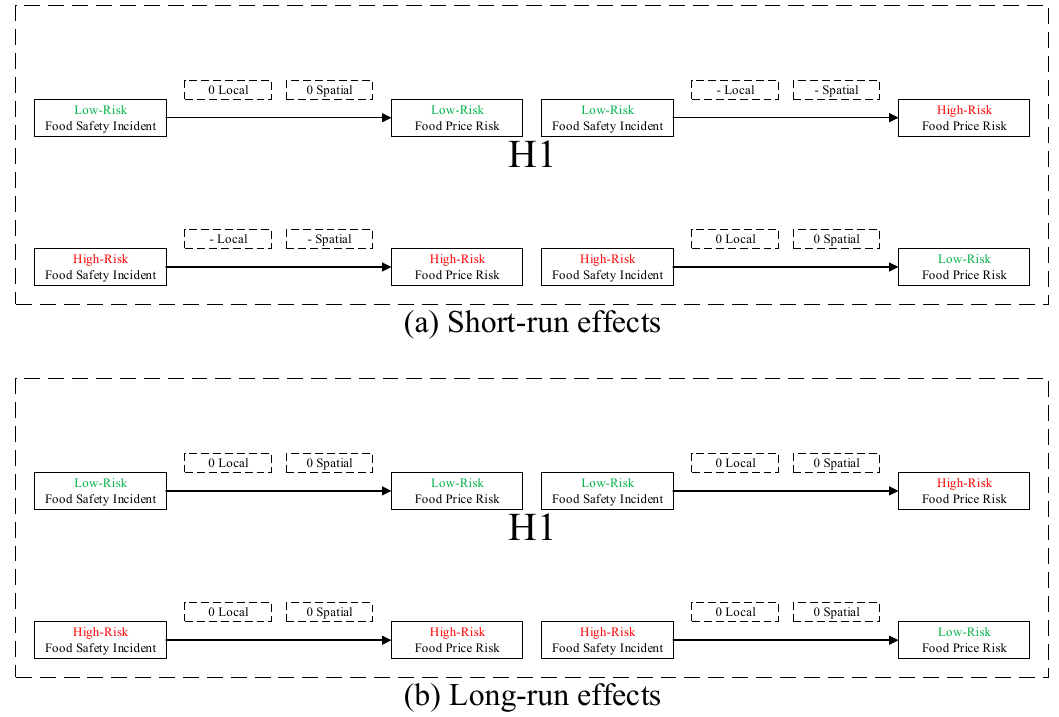
Figure 5. Test results for hypothesis H1. The symbols “0” and “-” show “insignificant” and “negative” spillovers, respectively. Source: Originally developed by the authors.